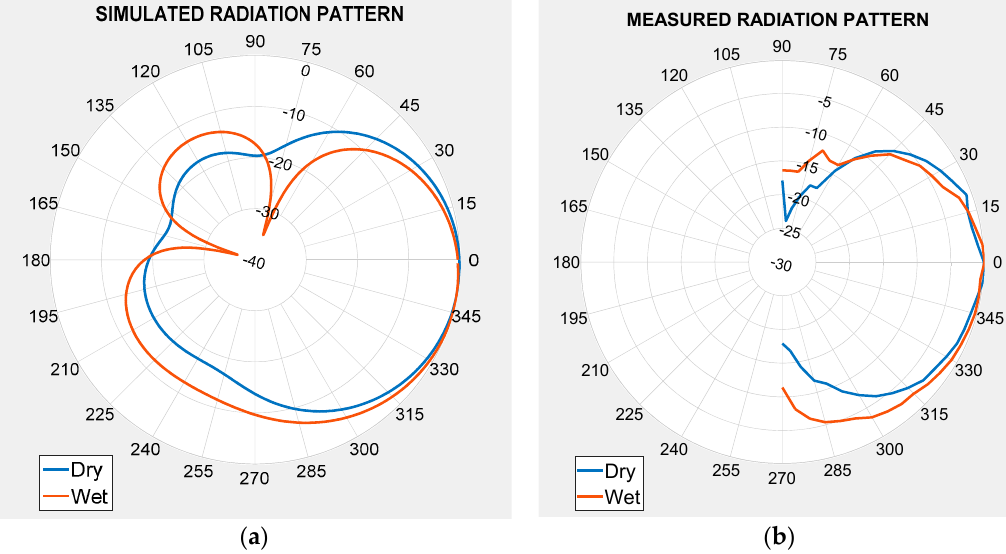
Figure 9. Radiation pattern of the antenna with hs = 6mm for the dry and wet conditions (1.59 g of water). ( a ) Simulation results and ( b ) measurement results.